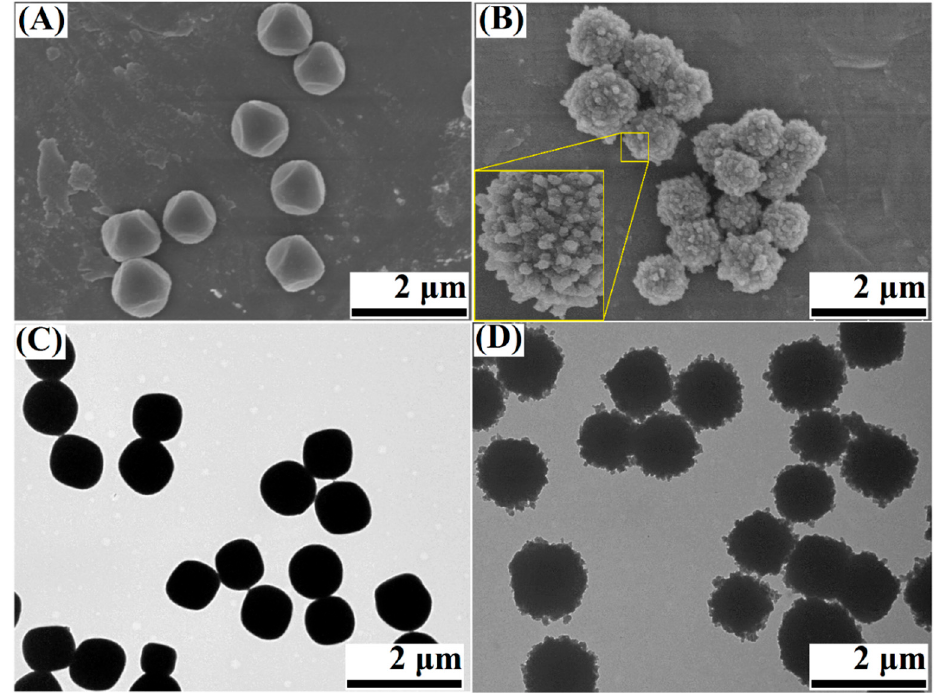
Figure 2. Field-emission scanning electron microscopy (FESEM) images ( A , B ) and TEM images ( C , D ) of Cu-BTC ( A , C ) and Cu-BTC@TiO 2 ( B , D ); a magnified microsphere surface is shown as an inset in ( B ).